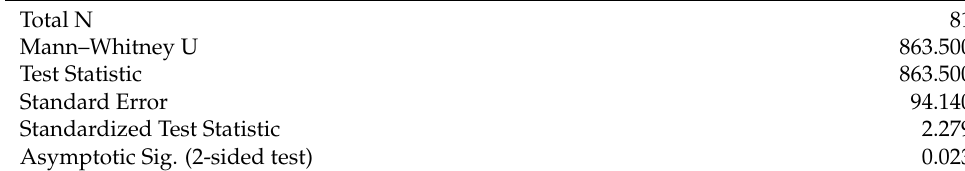
Figure 3. Independent samples Mann–Whitney U test results. Table 6. Independent samples Mann–Whitney U test summary.